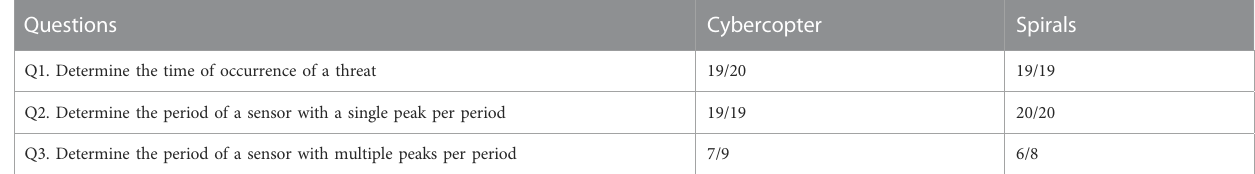
TABLE 3 Success rate of responses determining the characteristics of the alerts. For the third question, only DPIT301 ( set1 ) had a multiple peak period.